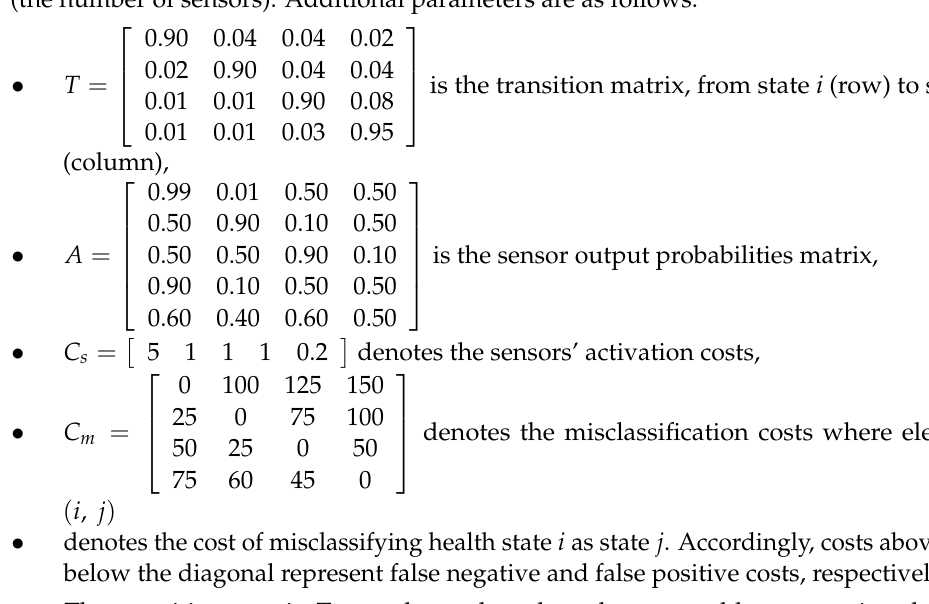
Figure 7. Ratio between total costs obtained by greedy and value iteration methods obtained over all patients for k values , for the following set parameters: ω = 0.5, C FN = 100, C FP = 50 .